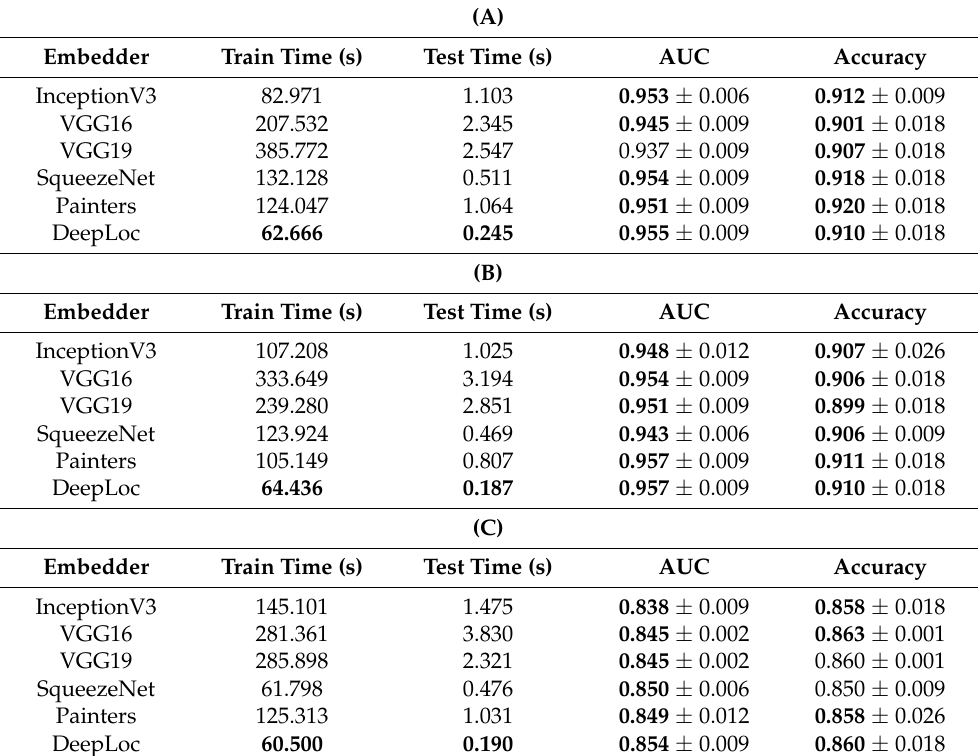
Table 1. Results of the classification tests by pre-trained CNNs on the covmingrad ( A ), cov ( B ), and ratio ( C ) image. AUC = Area Under the ROC Curve. Numbers in bold represent the best values obtained. (A) Embedder Train Time (s) Test Time (s) AUC